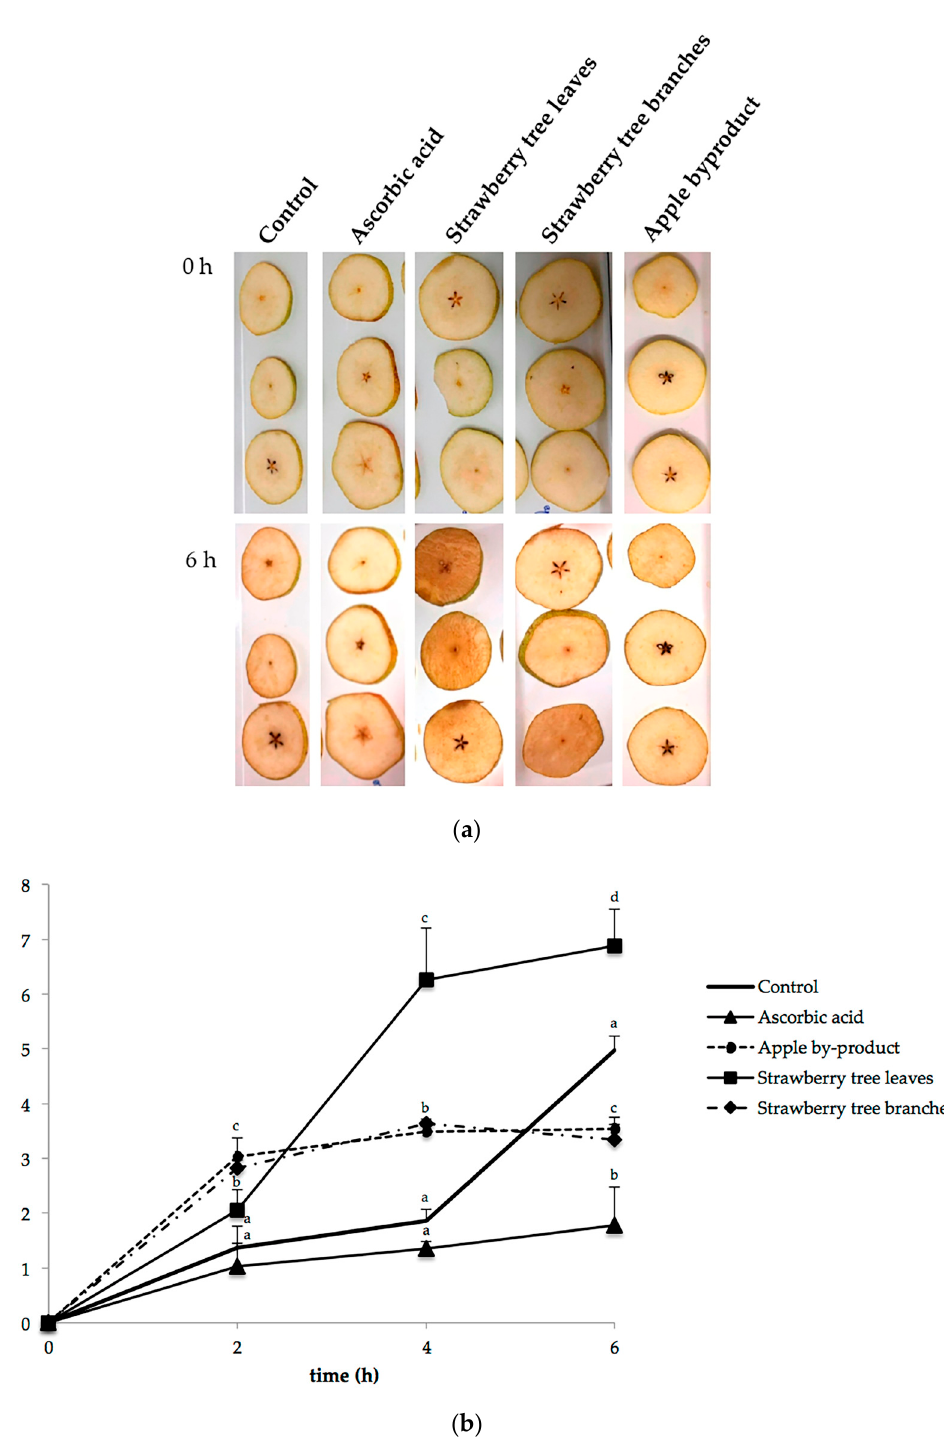
Figure 2. Results of fresch-cut pear fruits browning inhibition by NES: ( a ) Pear discs dipped in different NES solutions NES (discs sprayed with water and ascorbic acid were used as control and positive control, respectively) during 6 h. ( b ) The y-axis shows the color change ( ∆ L) of the treated discs, measured every 2 h interval during 6 h of exposure to air. Data are mean ± standard deviation (SD) (n = 5). Different superscript letters differ significantly by LSD test ( p < 0.05).